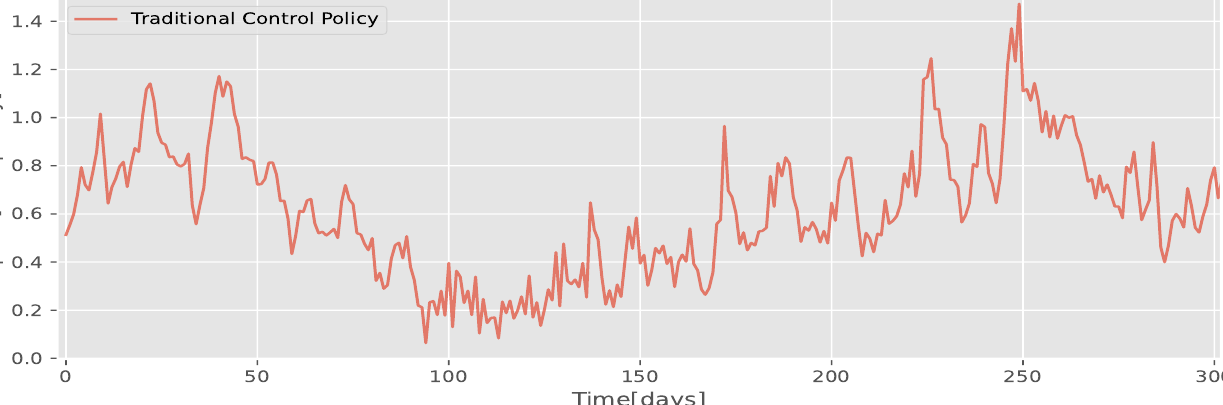
Figure 5. Price of heating over one heating season for a one-temperature zone system, of 30 m 2 . The price is price per day in